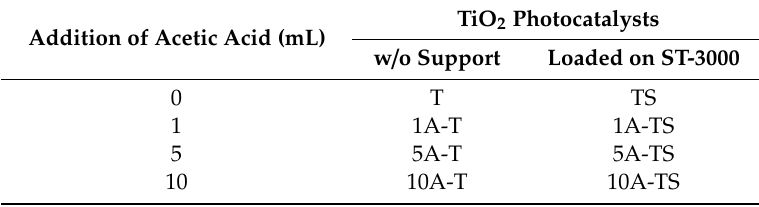
Table 1. The denotations of various TiO 2